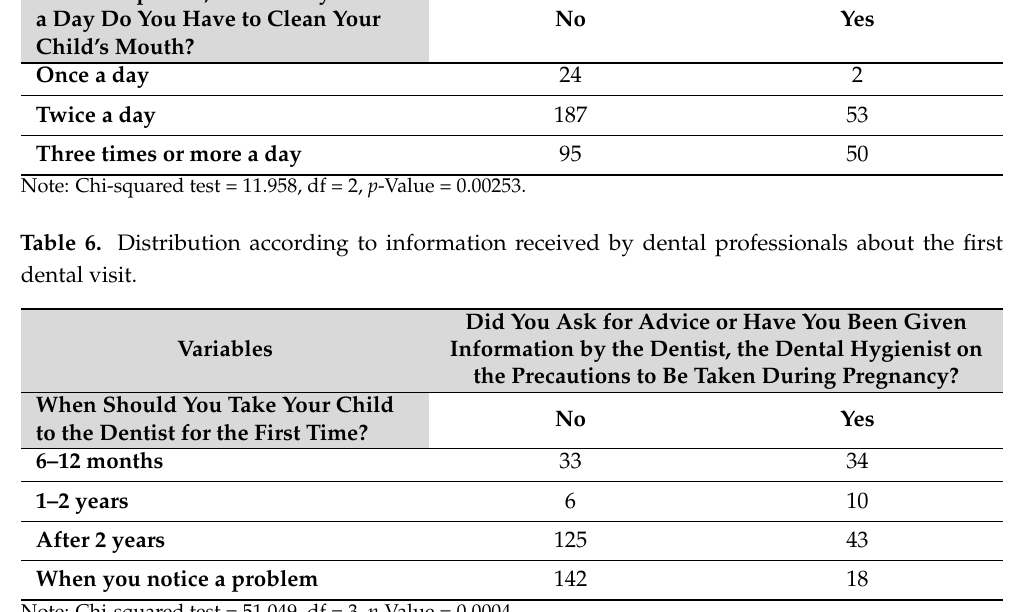
Table 5. Distribution according to information received by dental professionals about frequency of brushing. Did You Ask for Advice or Have You Been Given Variables Information by the Dentist, the Dental Hygienist on the Precautions to Be Taken during Pregnancy?